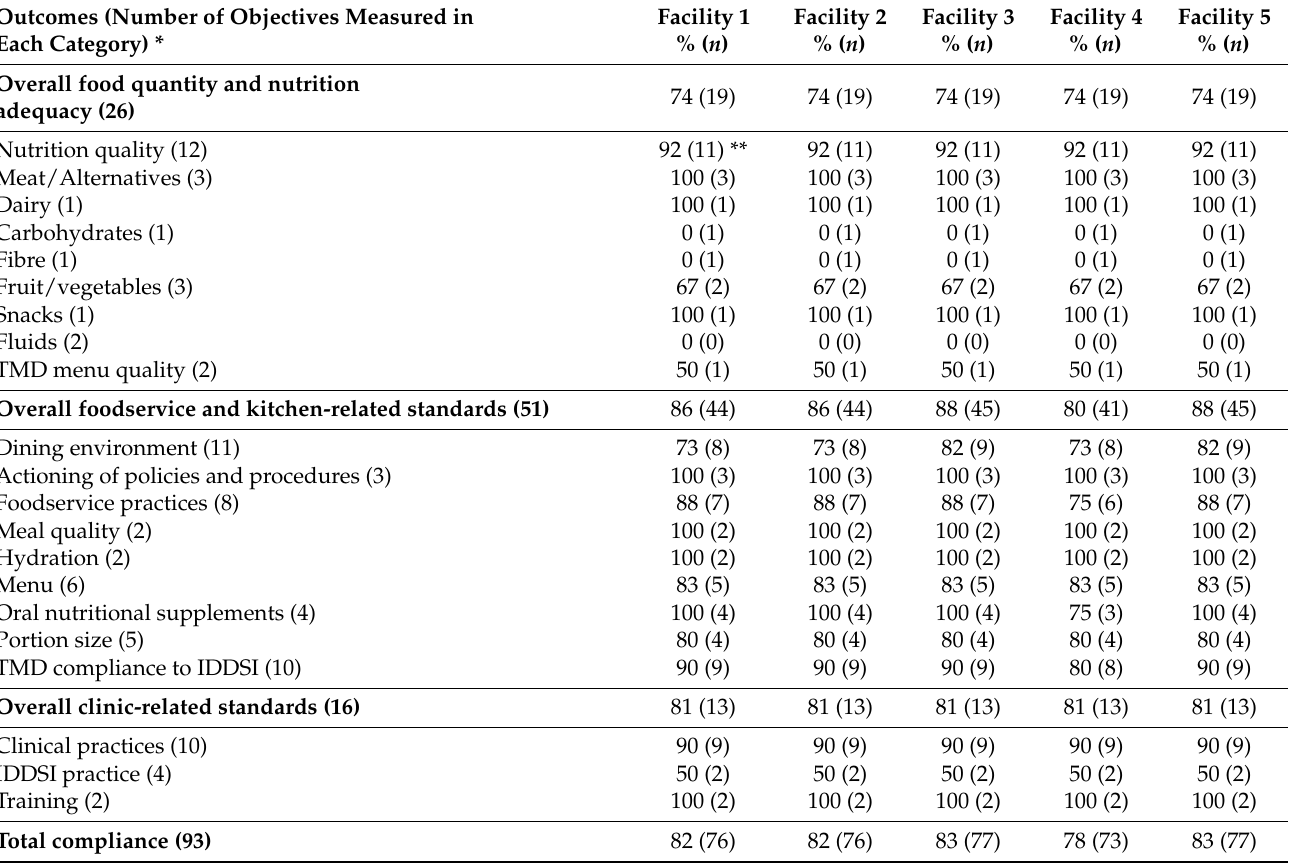
Table 1. Aged care texture-modified diet menu audit results: compliance with each subsection of Dietitian NZ foodservice and nutrition audit